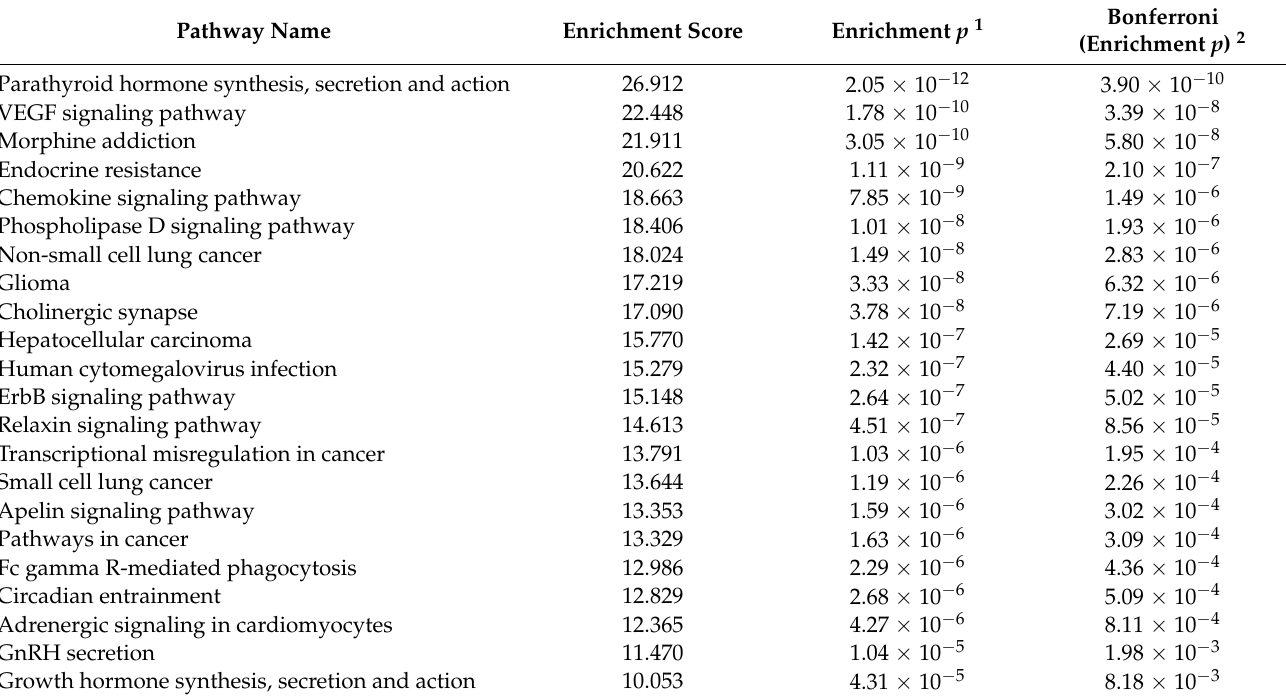
Table 5. Pathway enrichment of methylation of top-ranked sites, obtained in the epigenome-wide methylation analysis of smoking (5 levels), based on the Kyoto Encyclopedia of Genes and Genomes (KEGG). The pathway names are ranked according to the smallest p -values and corrected for